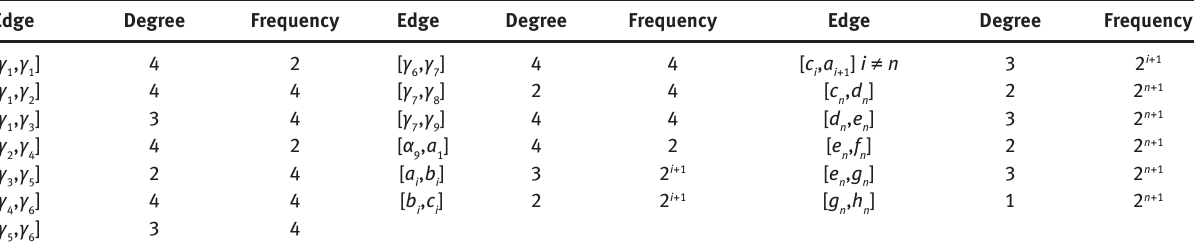
( n ) with n = 1 and n = 2